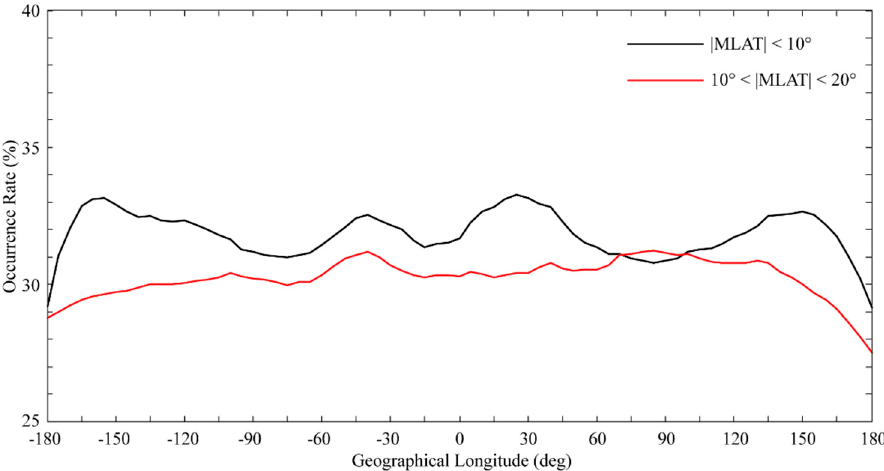
Figure 3. Longitudinal structure of scintillation event occurrences for nighttime (i.e., 18-06 LT) in magnetic low-latitude and equatorial region calculated from the CYGNSS direct GPS SNR data from 2017. The variations in the scintillation event occurrences calculated for magnetic low-latitude (10 MLAT | < 20 ) and equatorial ( | MLAT | < 10 ) region are represented by the red and black curves, respectively.